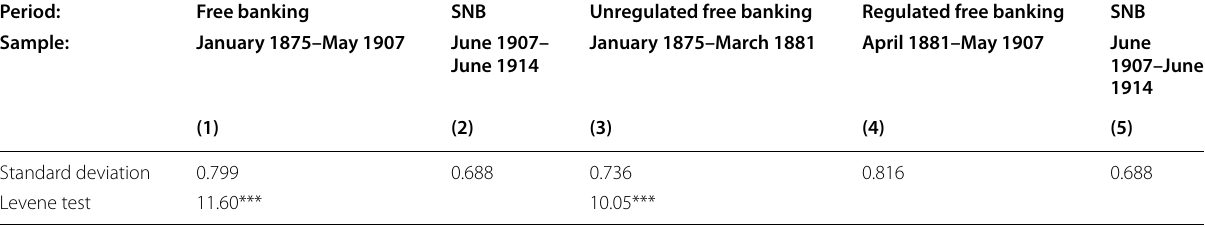
The discount rate is at a weekly frequency and refers to the data in Zurich as reported in Fig. 2. The total standard deviation across the sample with T observations between the beginning of January 1875 and the end of June 1914 equals 0.786. The Levene test is based on an analysis of variance (ANOVA) across G groups of the absolute difference from the mean (Levene, 1960). The test statistic is F-distributed with the number of degrees of freedom in the numerator equal to G , and T − G in the denominator. The null hypothesis is that the subgroup variances are equal. A rejection at the 10% level is marked by *, at the 5% level by **, and at the 1% level